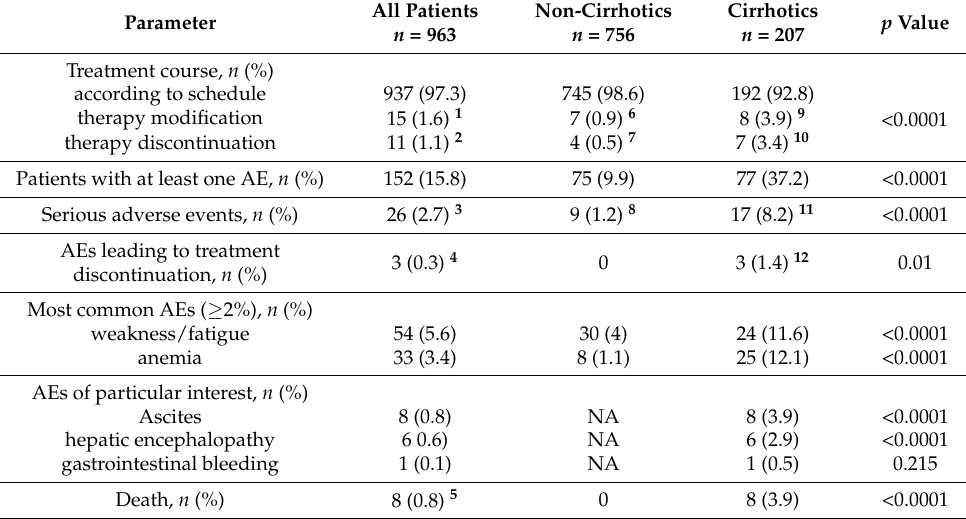
Table 8. Safety of DAA-Based